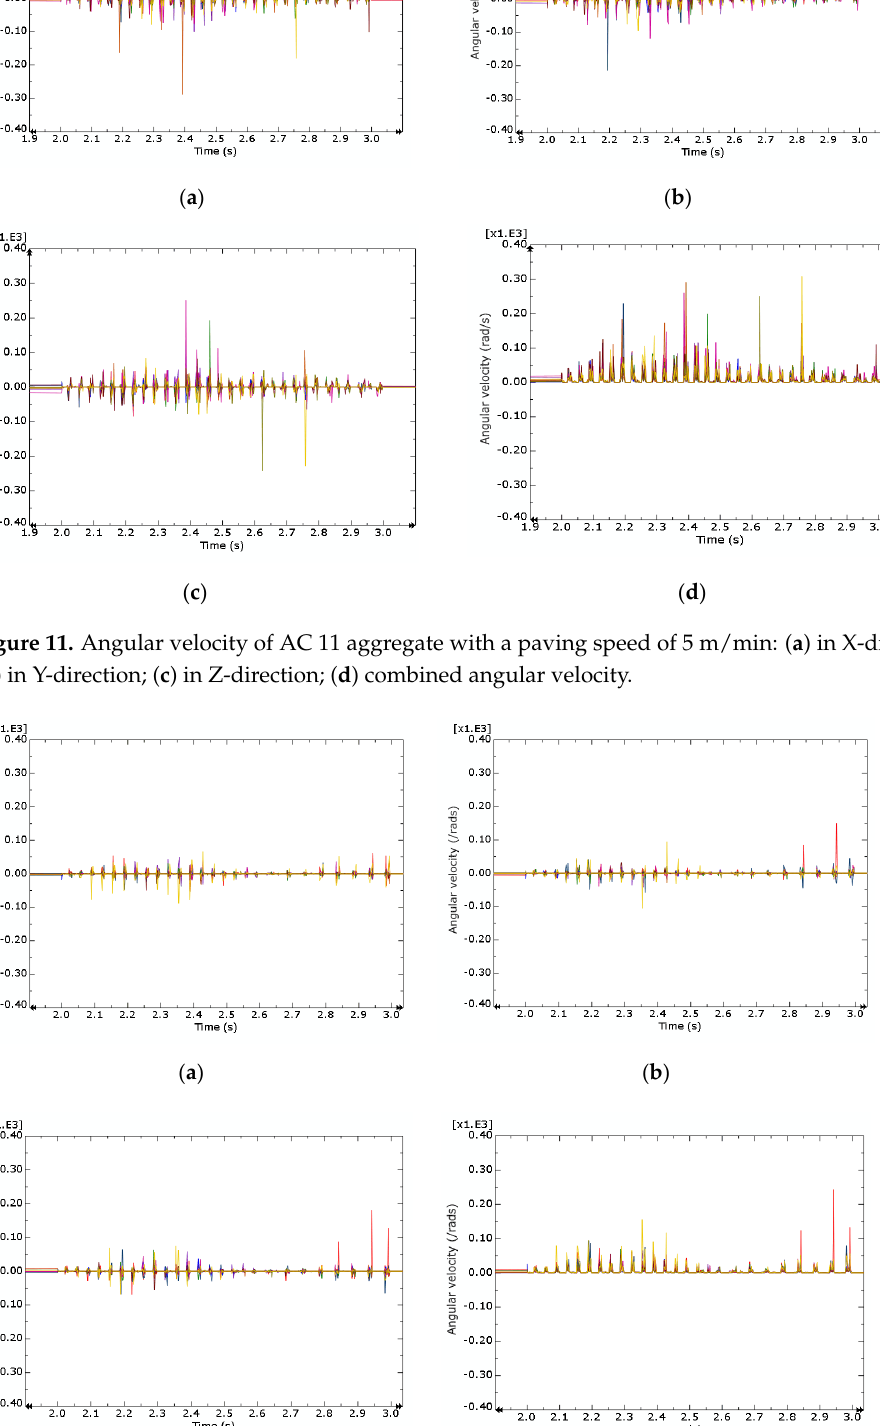
Figure 12. Angular velocity of AC 11 aggregate with a paving speed of 6 m/min: ( a ) in X-direction; ( b ) in Y-direction; ( c ) in Z-direction; ( d ) combined angular velocity. The asphalt aggregate seemed very active when the paving speed was set to 4 m/min, with angular velocities oscillating between − 0.4 rad/s and 0.4 rad/s, as indicated in the preceding subsection. When the speed was raised to 5 m/min while the other parameters remained constant, the angular velocity of the asphalt aggregate fell in all directions, with a maximum peak of 0.3 rad/s, indicating that the compaction was not as good as when the